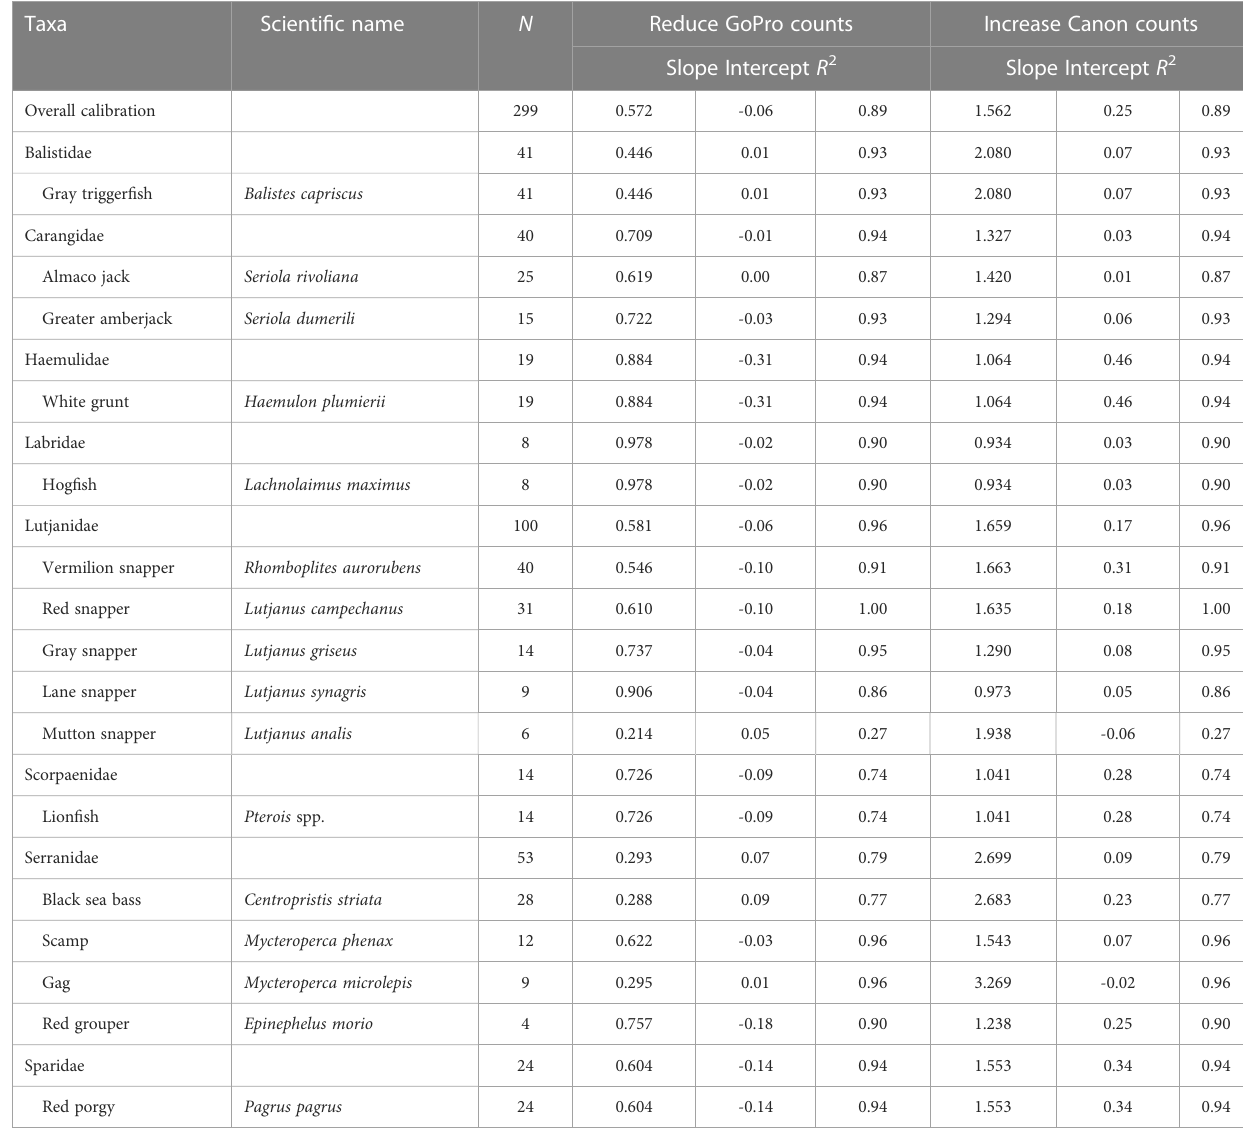
TABLE 1 Calibration information for the 16 reef fi sh species with a sample size ( N ) of at least 4, their associated families, and a fi t across all 16 species ( “ overall calibration ” ) as part of the 2014 side-by-side calibration study by the Southeast Reef Fish Survey along the southeast United States Atlantic